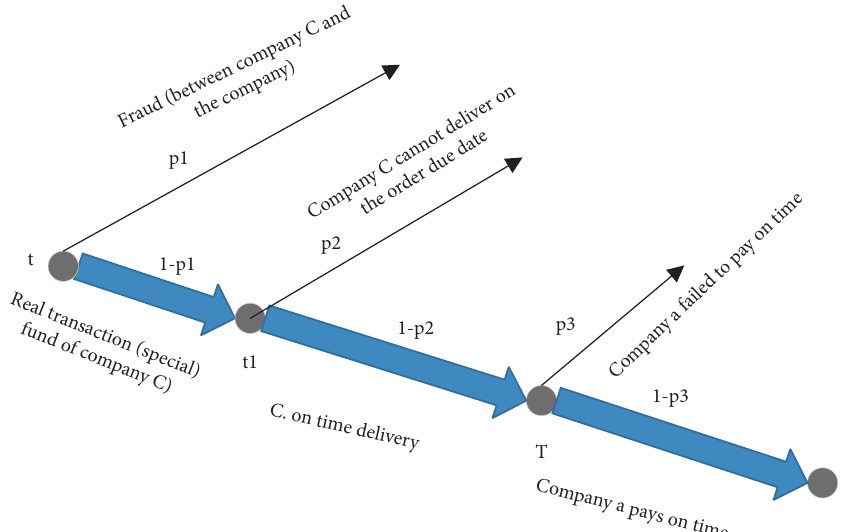
Figure 2: Sequential default process of order